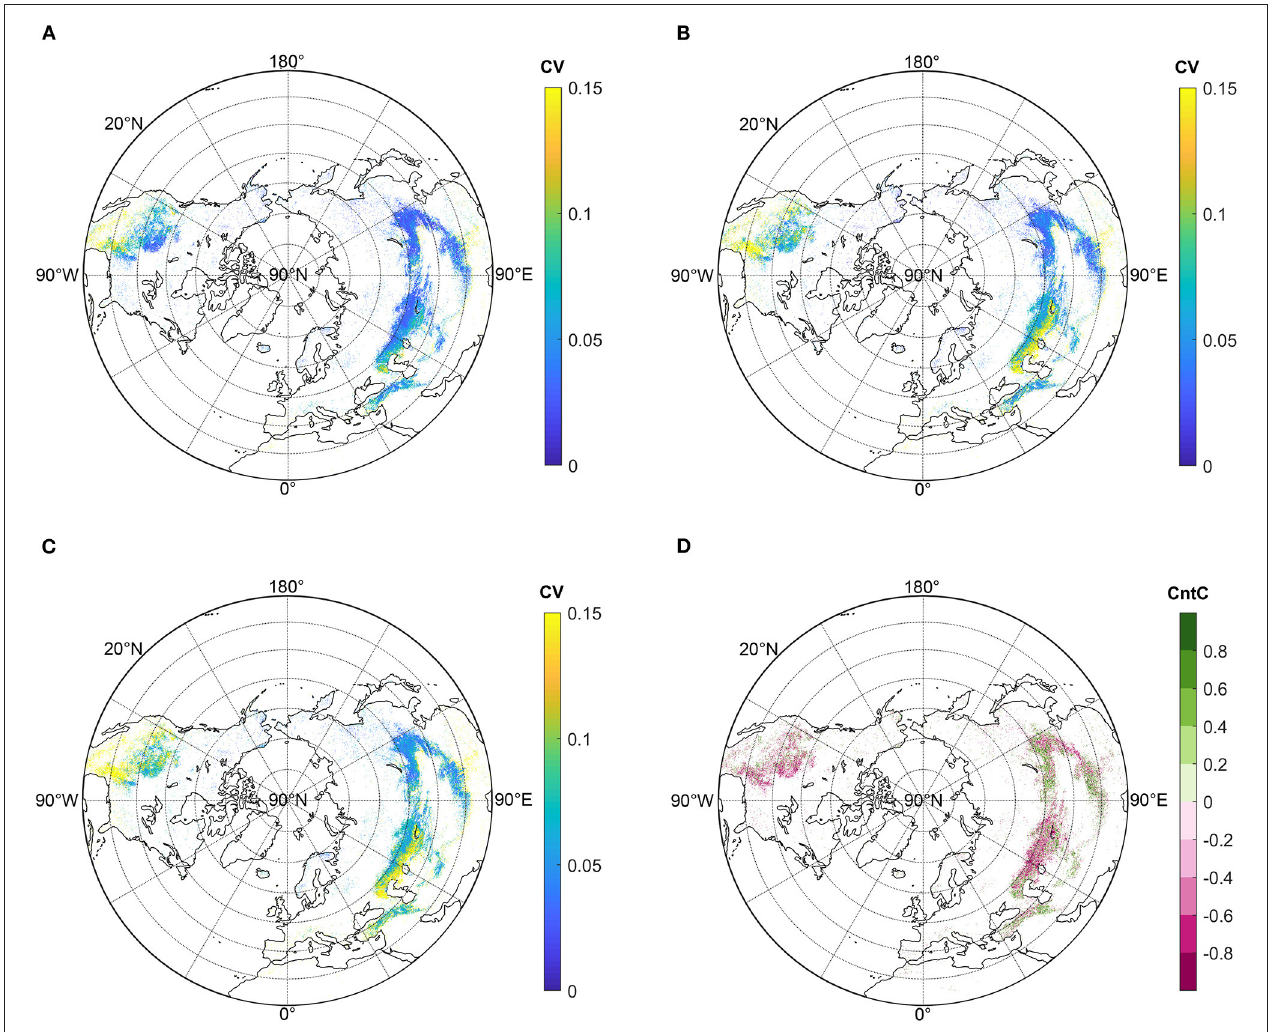
FIGURE 2 | Coefficient of Variance (CV) of SOS (A) , EOS (B) , and GSL (C) during 1982–2012; Contribution coefficient (CntC) (D)